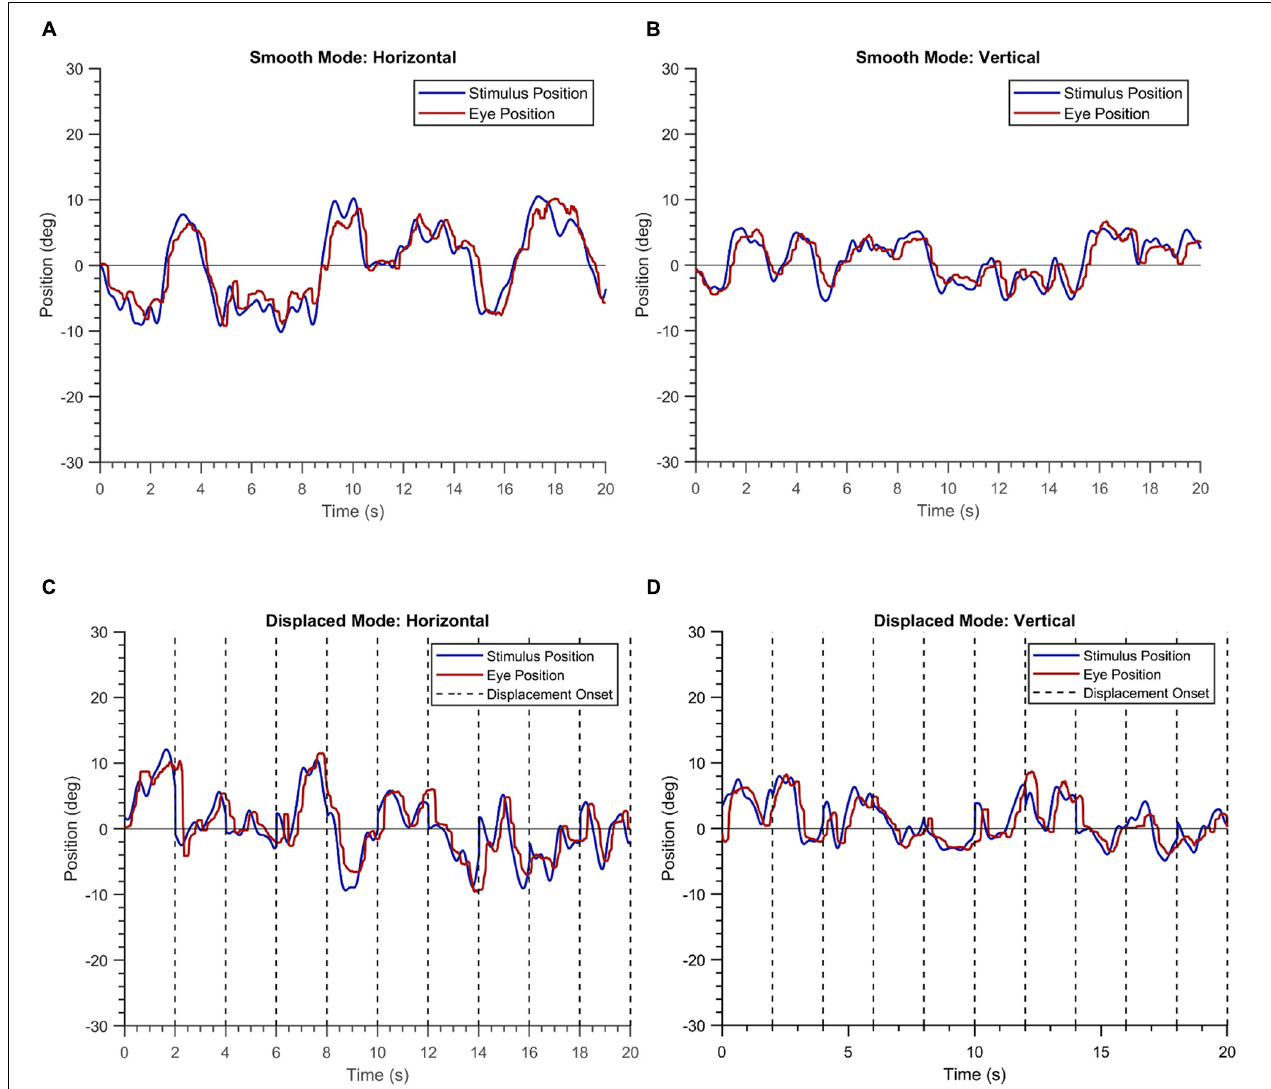
FIGURE 1 | Plots of a single trial of a healthy participant in the “smooth” (A,B) and the “displaced” mode (C,D) .